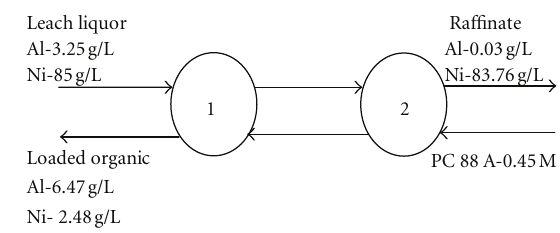
Figure 3: Two stage CCES for Al. Conditions: Al = 3.25 g/L; Ni = 85g/L; PC 88 A-0.45 M; equilibrium pH, 2.23.